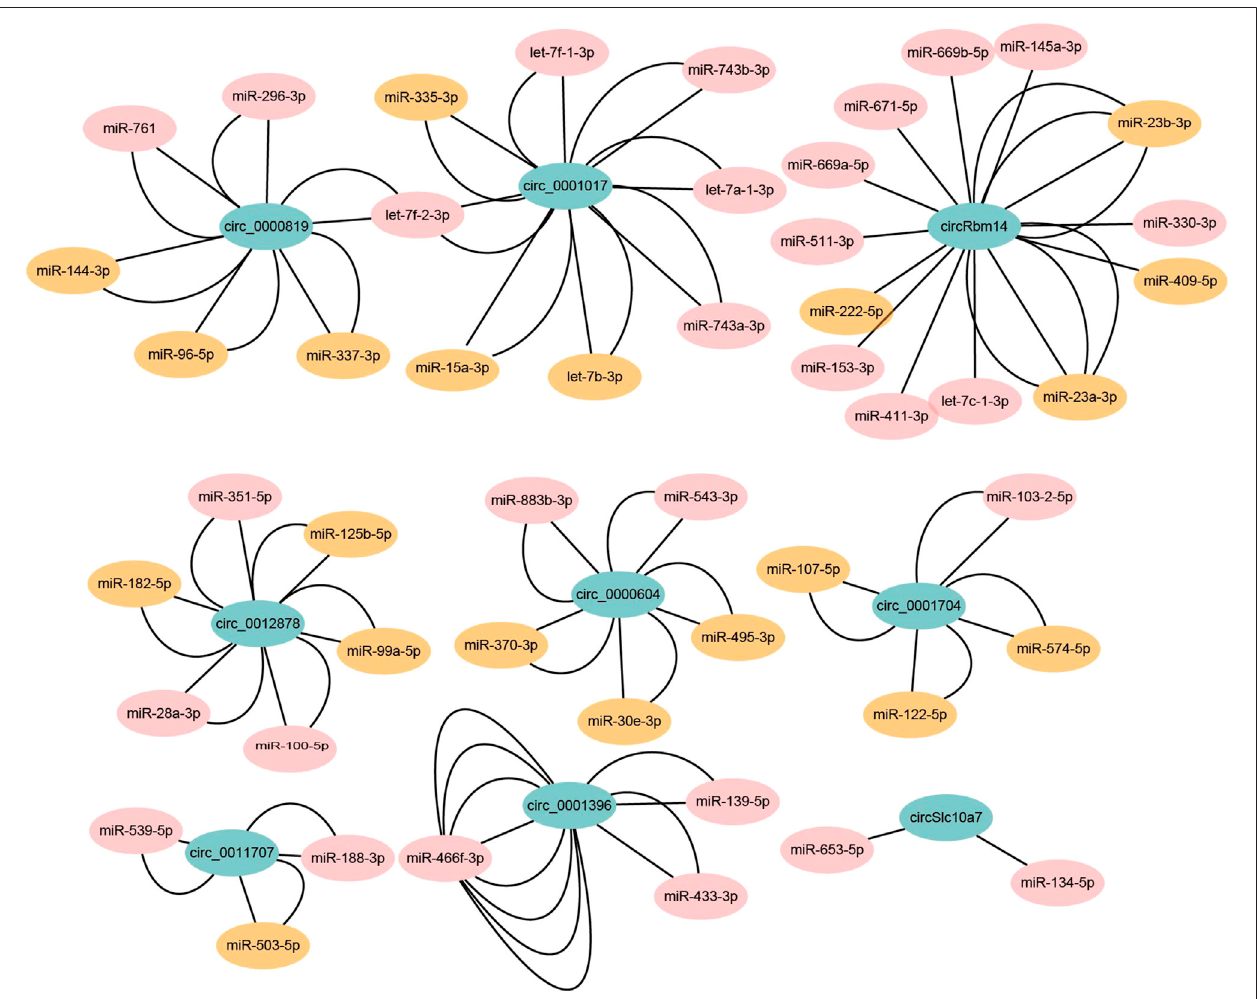
FIGURE 6 | The predicted circRNA-miRNA interaction networks. The potential miRNA binding sites of circRNAs were predicted by miRanda. The edge number represents the number of miRNA binding sites in the indicated circRNA sequences. The miRNAs with brown color indicate that these miRNAs are associated with adipogenesis or metabolic diseases according to HMDD (version 3.2) or previous